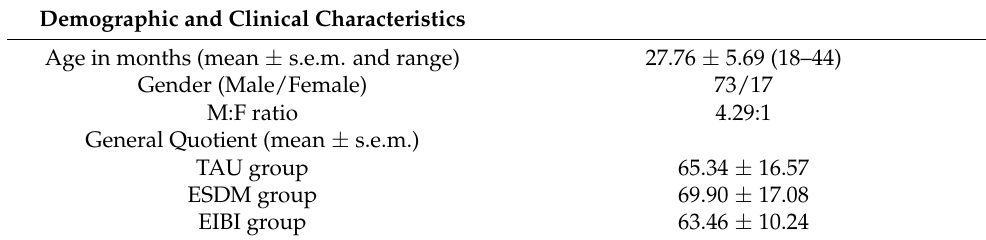
Table 1. Baseline demographic and clinical characteristics of the sample (N = 90). Demographic and Clinical